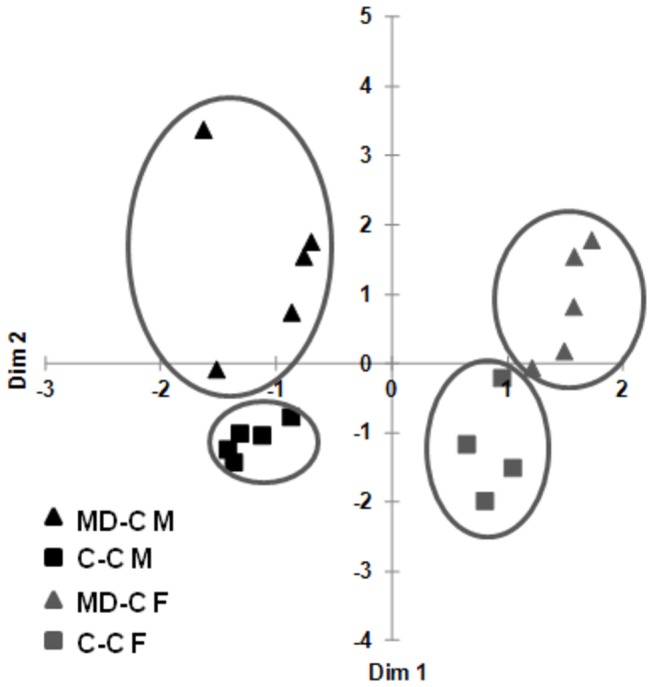
Fecal (F) and colonic mucosal (M) microbiome separation in prenatally MD supplemented (MD-C) young adult mice.Cecal content (feces) and colonic mucosal scrapings from non-DSS exposed C-C and MD-C animals were processed for microbiome analysis at P90. Principal coordinates analysis (PCoA) of weighted UniFrac measures showed separation of fecal and mucosal microbiomes in the prenatally MD supplemented (MD-C) mice compared to the control cross fostered group (C–C). N=5 per group.